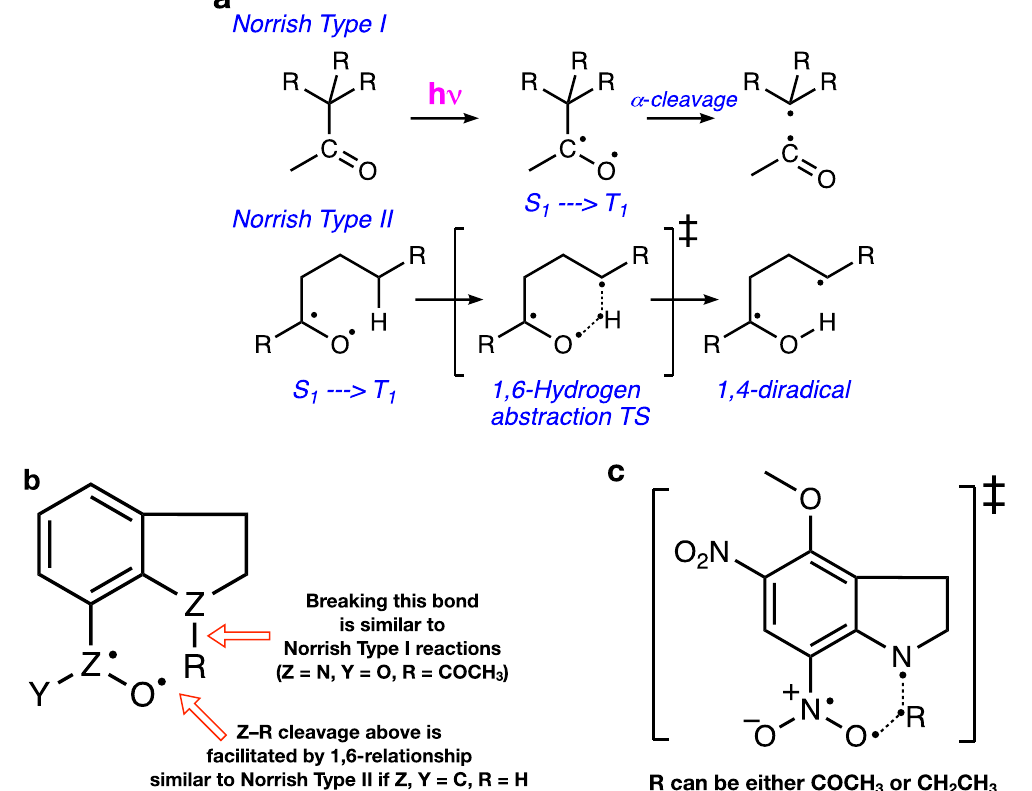
Figure 5. Schematics of the Norrish type reactions ( a ). The MP pathway combines both Norrish type I and type II characteristics ( b ). Breaking the Z–R bond (Z=N, R=COCH 3 ) results in a Norrish type I reaction, while the adjacent Z–O bond is in a 1,6-relationship (Norrish type II) and facilitates the cleavage of Z–R. Panel ( c ) shows the key migration transition state. If R=CH 2 CH 3 , the reaction loses the Norrish type I characteristic, and hence, not suprisingly, higher in energy by about 15.5 kcal mol −1